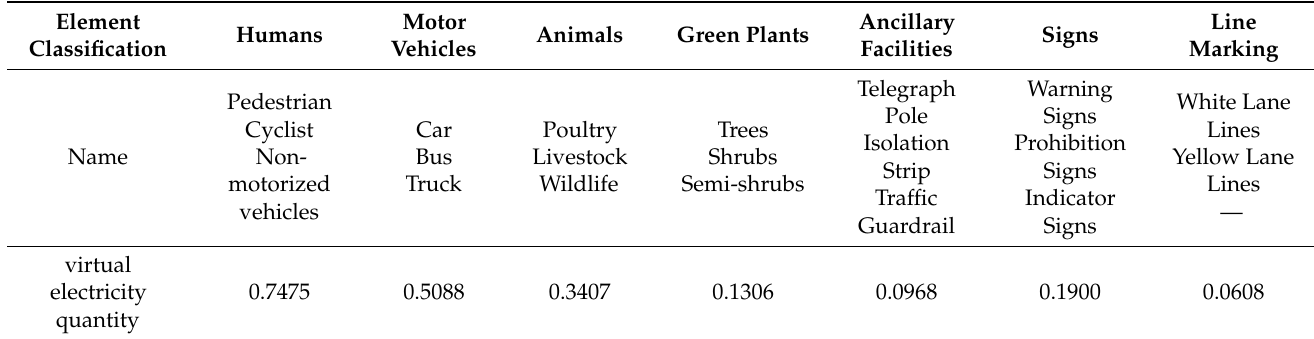
Table 2. The virtual electricity quantity of each category of elements.